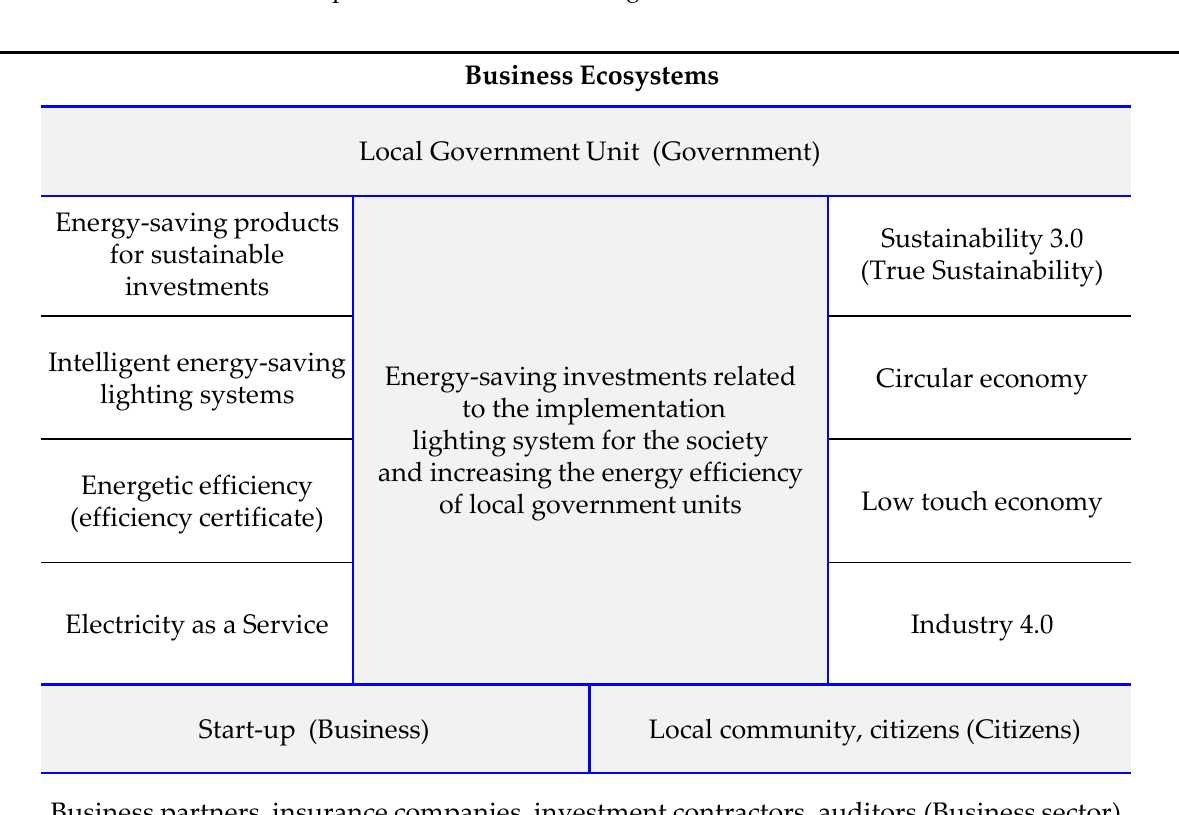
Figure 1. Conceptual elements of the research area. Source: own elaboration.